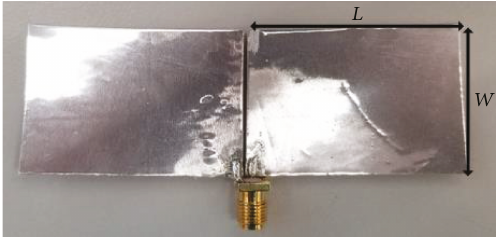
Figure 3: Foldable antenna.